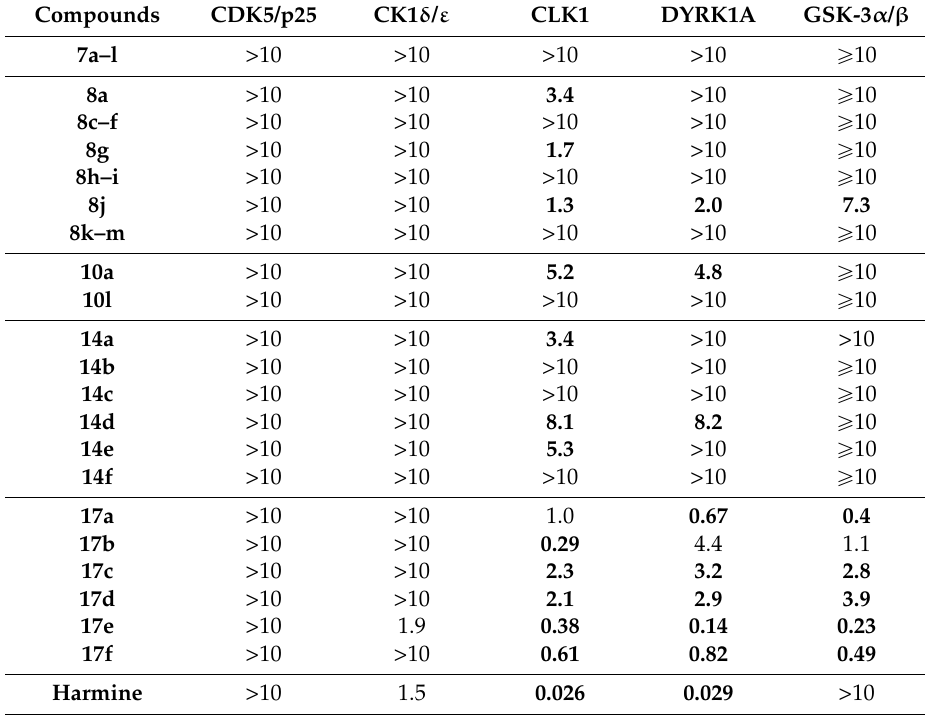
Table 7. Kinase inhibitory activity a,b,c of the thiazolo[5,4- f ]quinazoline series ( 7a – l , 8a – m , 10a and 10l , 14a – f and 17a – f